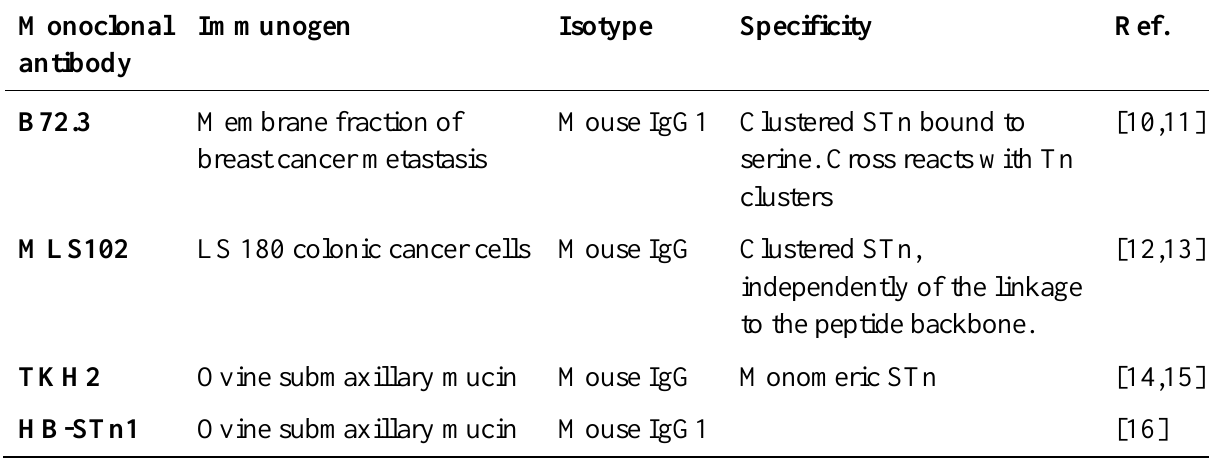
Table 1. Most used anti-STn monoclonal